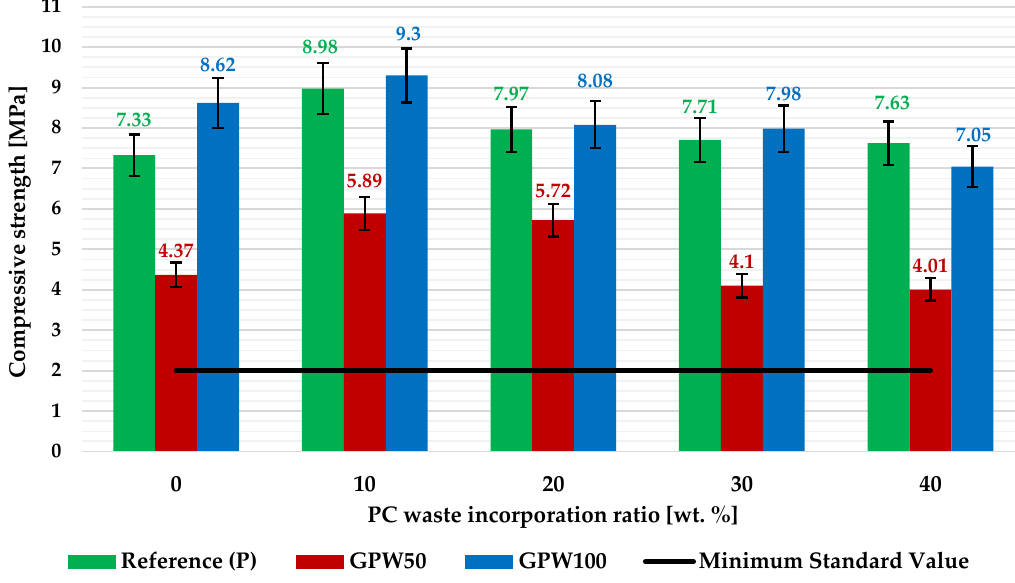
Figure 6. Compressive strength values for the developed gypsum plasters with error bars.